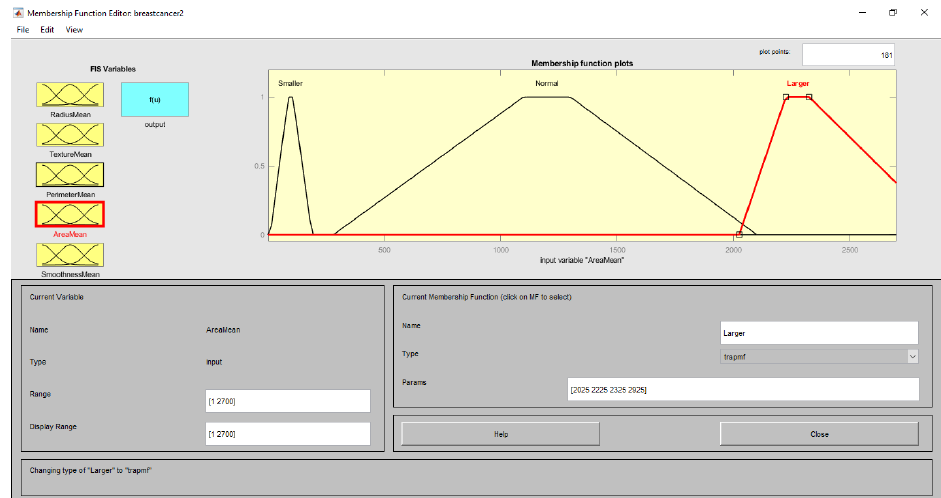
Figure 17. Membership functions of the linguistic variables of area mean input.